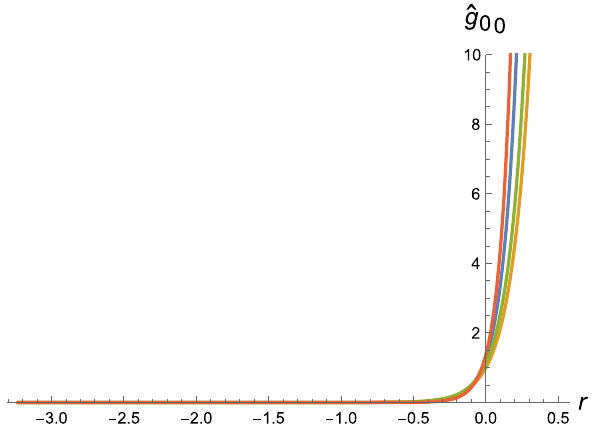
Fig. 26 Profiles of the eleven-dimensional metric component ˆ g 00 for the RG flows given in Fig.